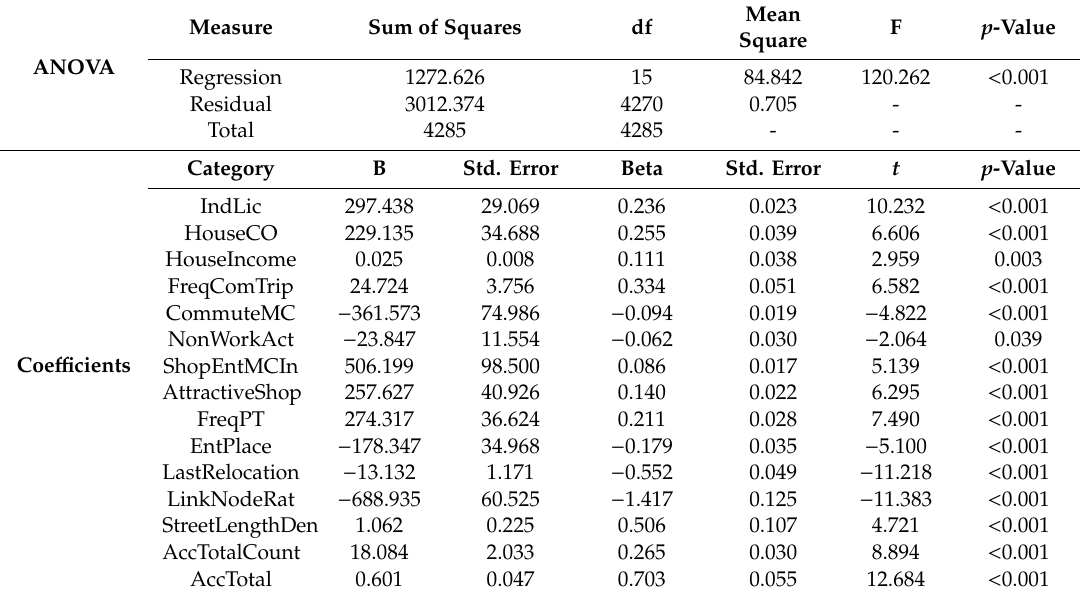
Table 5. The WLS model for the Middle East and North Africa (MENA) region including the coe ffi cient estimates and F-test results (R 2 =